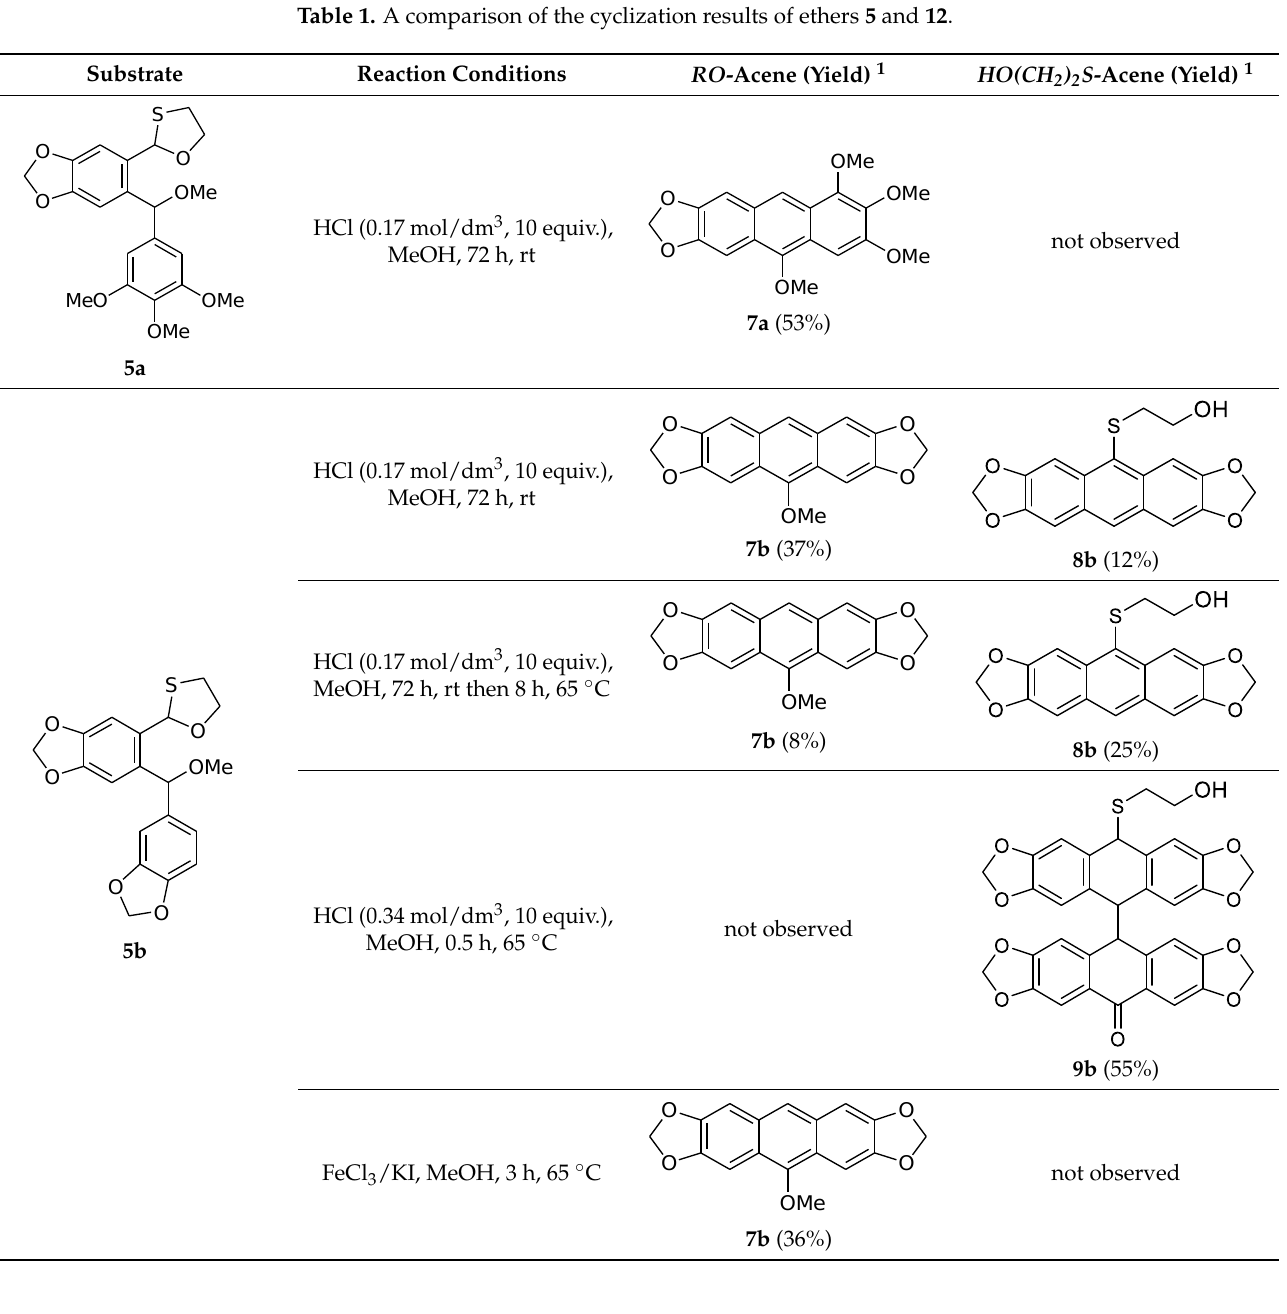
Table 1. A comparison of the cyclization results of ethers 5 and 12 .